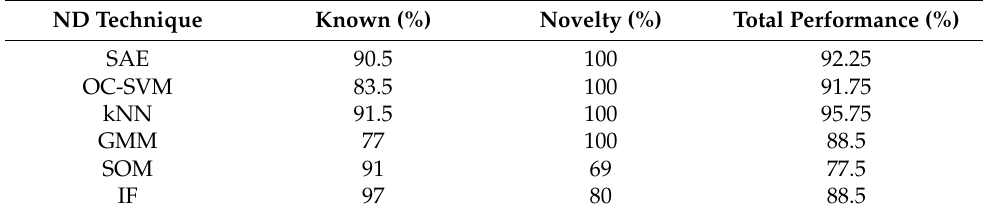
Table 8. Numerical results of the novelty detection obtained for the fourth case study of the